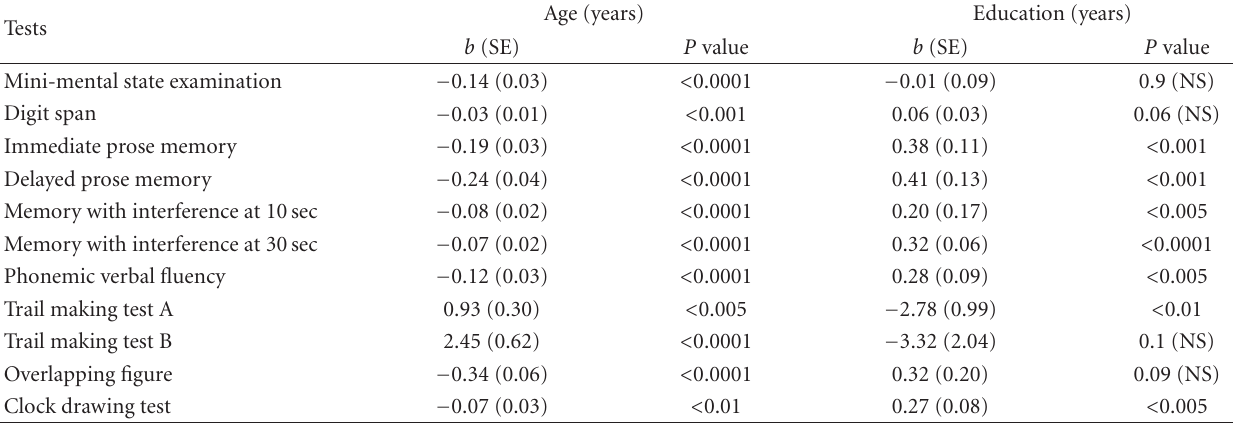
Table 2: Multiple regressions of the neuropsychological tests with age and education.